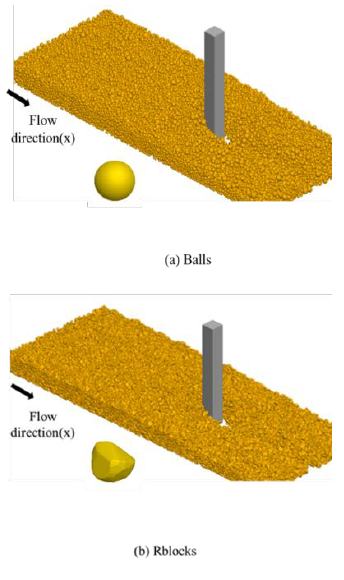
Fig. 4.: Two simulations with different shapes of particles: (a) balls and (b) r-blocks.